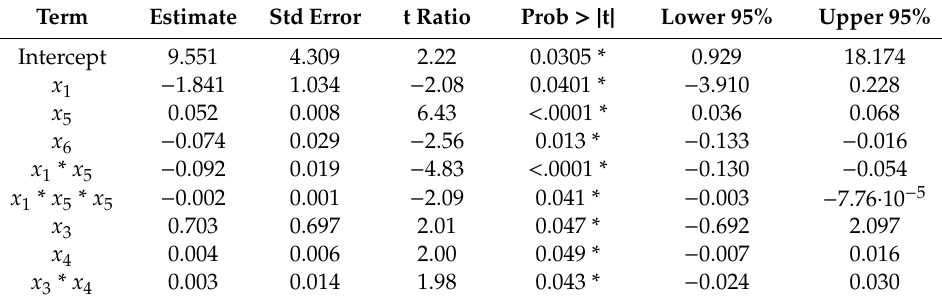
Table 10. Estimation of model